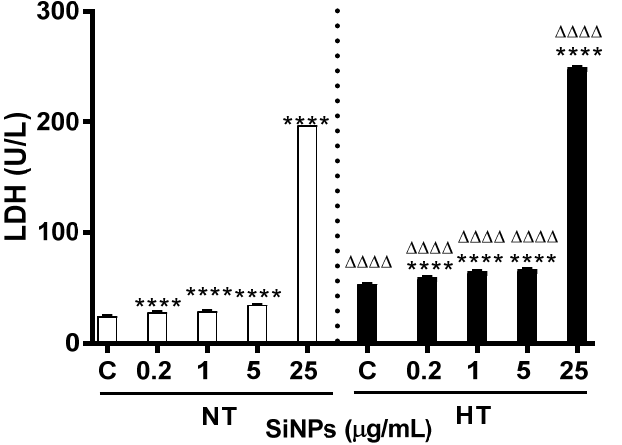
Figure 6. Effect of various concentrations ( μ g/mL) of silica nanoparticles (SiNPs) on lactate dehy ‐ drogenase concentration in incubated normotensive (NT) and hypertensive (HT) rat erythrocytes. Data are mean± SEM ( n = 6 in each group). Statistical analysis by one ‐ way analysis of variance (ANOVA) followed by the Holm–Sidak multiple comparisons test. **** p < 0.0001 vs. respective con ‐ trol and ΔΔΔΔ p < 0.0001 vs. respective concentration in NT group.